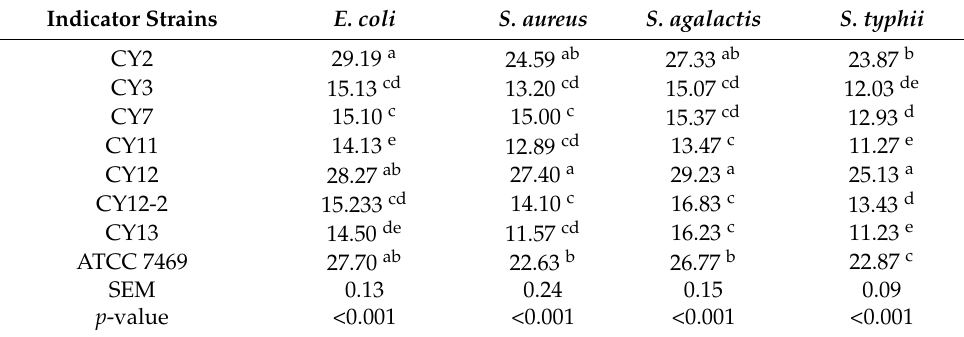
Table 1. Pathogen inhibition by Lactobacillus supernatant. Indicator